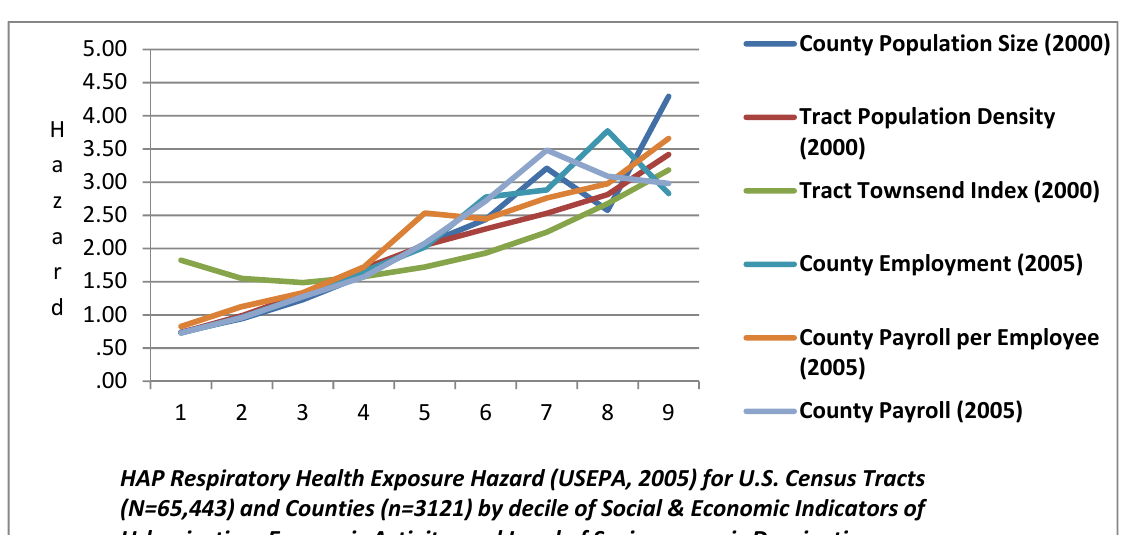
Figure 6. Respiratory Exposure Hazard at Progressive Deciles of Social & Economic Characteristics of Tracts and